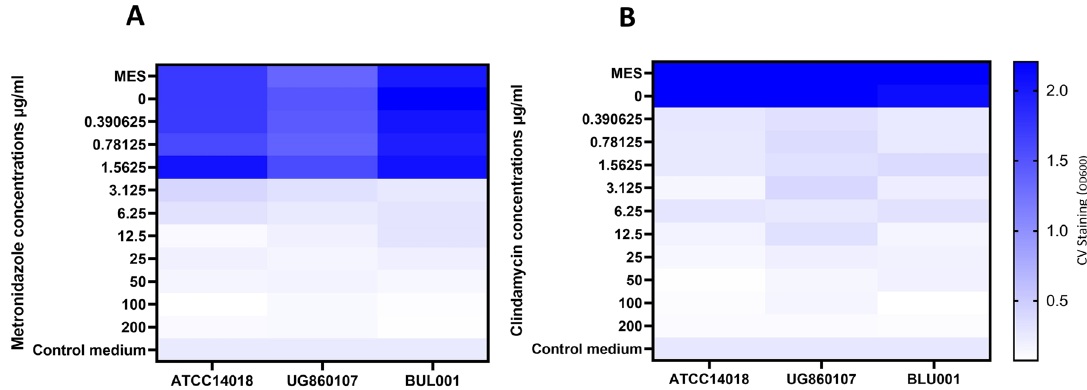
Fig. 3 Antibiotic bio fi lm prevention activity: Bio fi lm prevention assays using G. vaginalis ATCC14018, G. vaginalis UG860107 and G. vaginalis BUL001 cultures. Final concentrations of A metronidazole or B clindamycin from 0.39 to 200 μ g/ml, were used to disrupt bio fi lms. OD 600 readings are the average of biological triplicates. Controls: MES corresponds to bacteria with MES buffer and control medium is the no bacterial